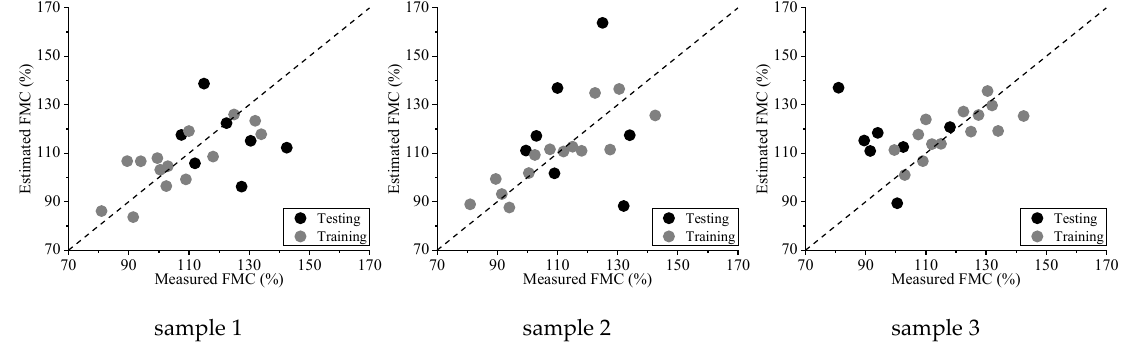
Figure 12. Scatterplots of training and testing results from Landsat 8 OLI data. Table 1. Root mean square error ( RMSE) between measured and estimated FMC.